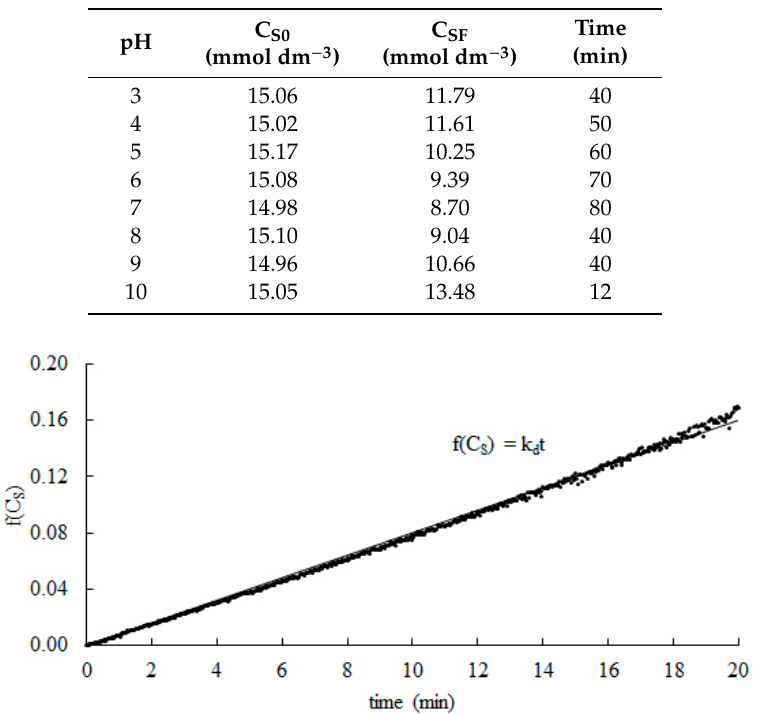
Figure 2. Typical plot of integrated rate equation for catalytic activity of catalase. Experiments were carried out at 25 °C and pH = 7.